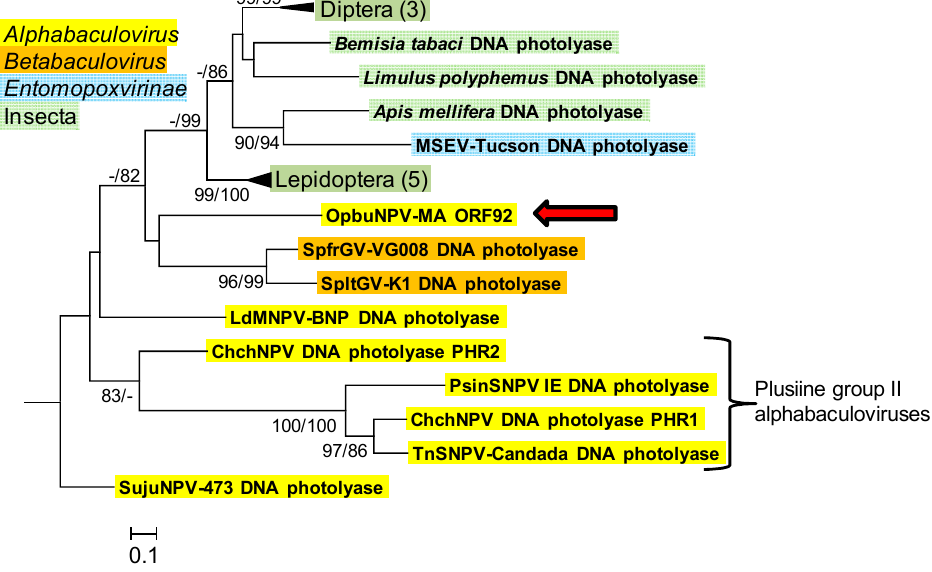
Figure 7. Phylogenetic inference from aligned viral and insect DNA photolyase homologs. An ML phylogram inferred from the alignment of DNA photolyase amino acid sequences is shown with bootstrap values (>50%) at interior branches for ME and ML analysis (ME/ML) where they occur. The sequence for Bacillus cereus ATCC 14579 DNA photolyase (GenBank accession No. AAP10079) was included as an outgroup. The classification of each taxon is indicated with a color-coded text background. Branches for DNA photolyases from the insect orders Diptera and Lepidoptera are collapsed, and the numbers of taxa in each of these nodes are indicated in parentheses. The OpbuNPV sequence is indicated with a red arrow, and sequences from alphabaculoviruses of the lepidopteran subfamily Plusiinae are indicated with a bracket. The virus and insect taxa and their accession numbers are as listed in Table S1.